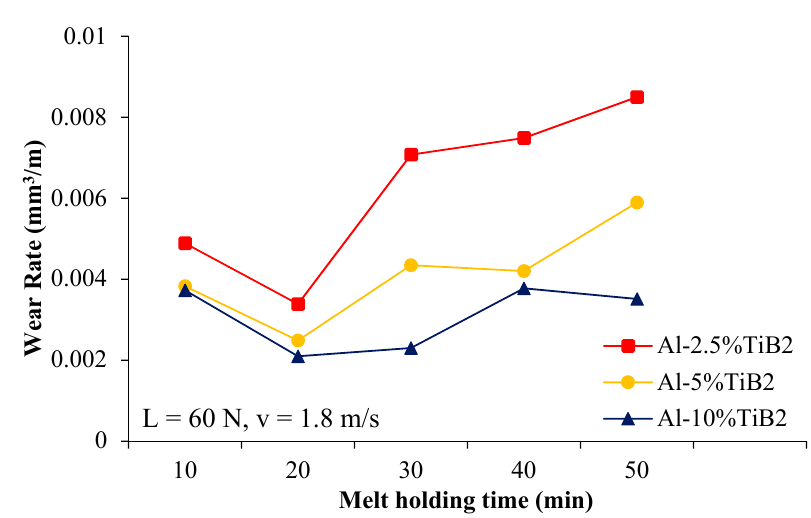
Figure 8. Influence of melt holding time on sliding wear rate for different Al ‐ TiB 2 composites.